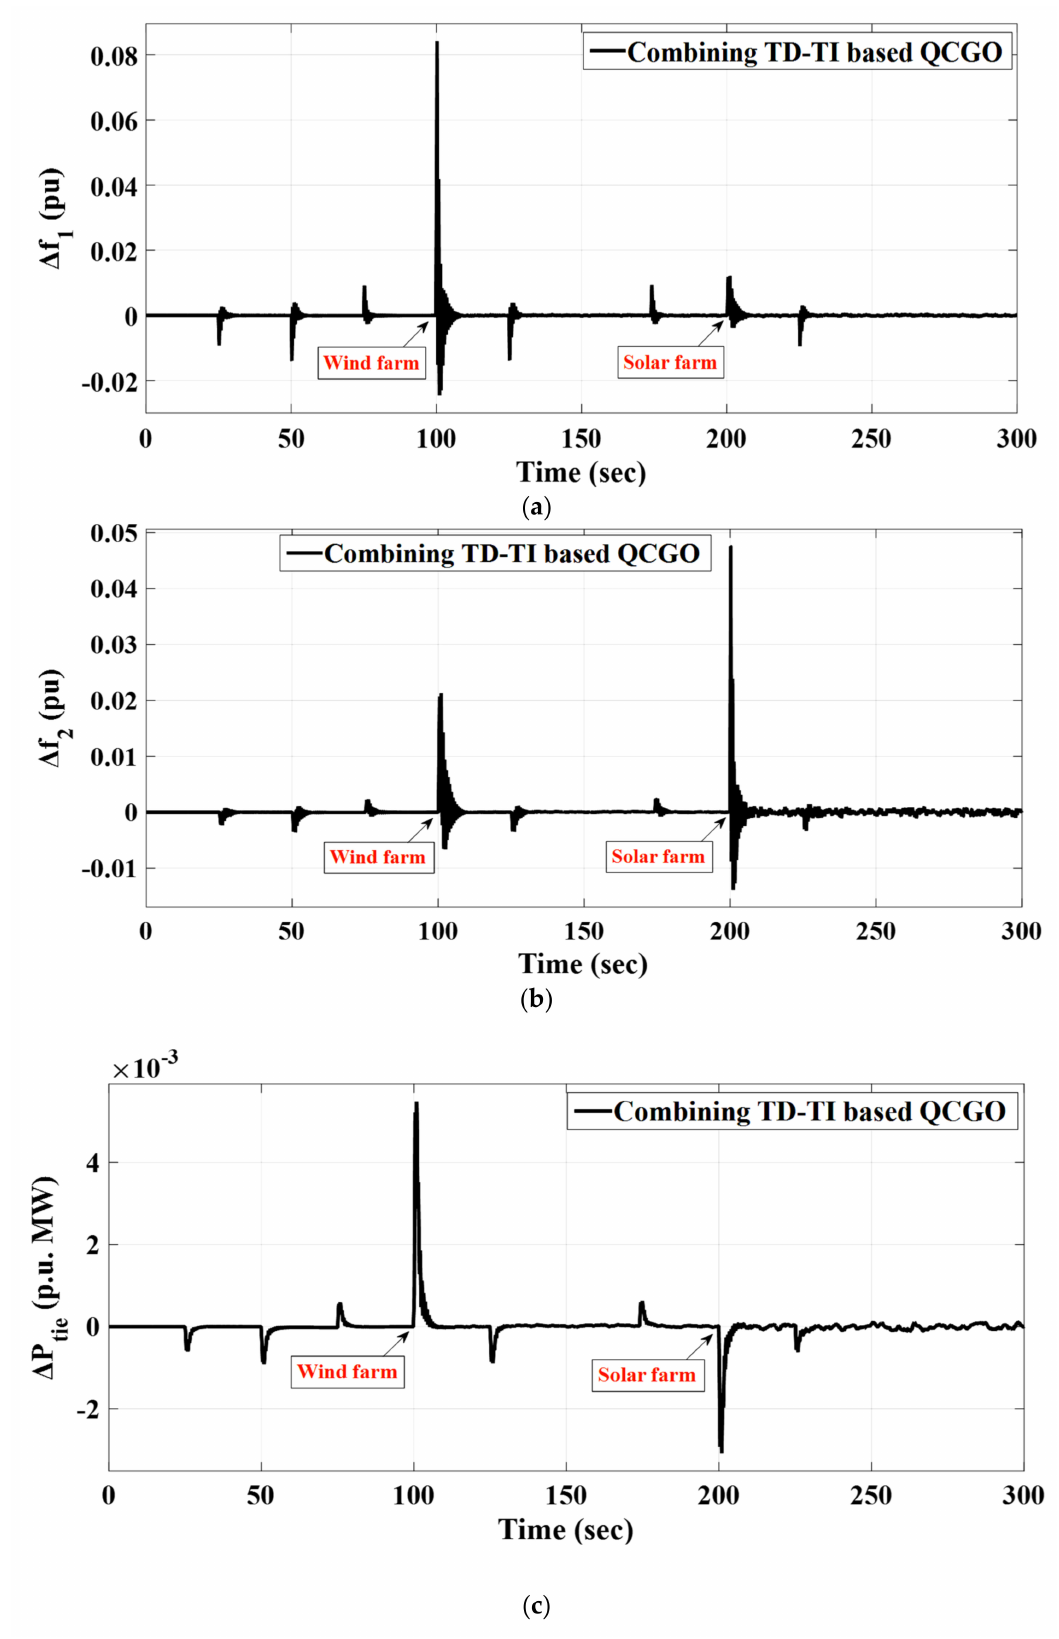
Figure 26. Dynamic power grid responses in case C: ( a ) ∆ f